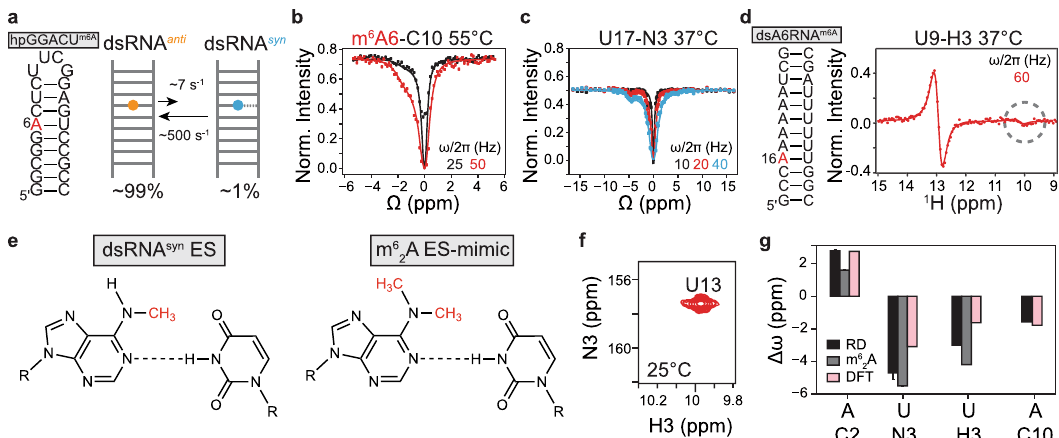
Fig. 4 Characterizing the conformation of the ES intermediate. a The hpGGACU m 6 A hairpin construct with the m 6 A site highlighted in red (left) and exchange parameters between dsRNA anti and dsRNA syn measured at T = 55 °C (right). b 13 C CEST pro fi le measured for m 6 A6-C10 in hpGGACU m 6 A at T = 55 °C. c 15 N CEST pro fi le measured for U17-N3 in hpGGACU m 6 A at T = 37 °C. d The dsA6RNA m 6 A duplex (left) and 1 H CEST pro fi le for U9-H3 at T = 37 °C (right). The minor peak is highlighted in the gray circle. e Chemical structures of proposed dsRNA syn ES and m 6 15 N, 1 H] 2 A ES mimic. f 2D [ HSQC spectra of U13-N3 15 N-site-labeled dsGGACU m 6 2 A at T = 25 °C. g Comparison of the chemical-shift differences ( Δ ω ES − GS = ω ES − ω GS ) measured using RD in hpGGACU m 6 A (A C2/C10, U-N3) and dsA6 m 6 A (U H3) at T = 37 °C (RD), when taking the difference between the chemical shifts measured for dsGGACU m 6 2 A and dsGGACU m 6 A (m 6 2 A) and calculated using DFT as the difference between an m 6 (syn)A···U conformational ensemble and a Watson – Crick m 6 A( anti ) – U bp (DFT) (see ” Methods ” section). Values for m 6 2 A C10 are not shown because it is the site of modi fi cation. Solid lines in panels ( b – d ) denote a fi t to the Bloch – McConnell equations to a two-state exchange model (see ” Methods ” ). RF fi eld powers for CEST pro fi les are color- coded. Data for CEST pro fi les in panels ( b – d ) were presented as mean values ± 1 s.d. (smaller than data points) from n = 3 independent measurements of peak intensities at zero relaxation delay (see ” Methods ” ). Data for Δ ω (panel g ) were presented as mean values ± 1 s.d. from Monte Carlo simulations (number of iterations = 500) for one CEST measurement as described in ” Methods ” section. Source data for panel ( g ) are provided in the Source Data fi